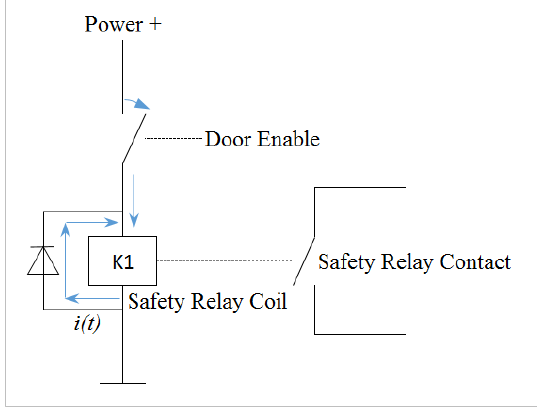
Fig. 3. Transient response of RL